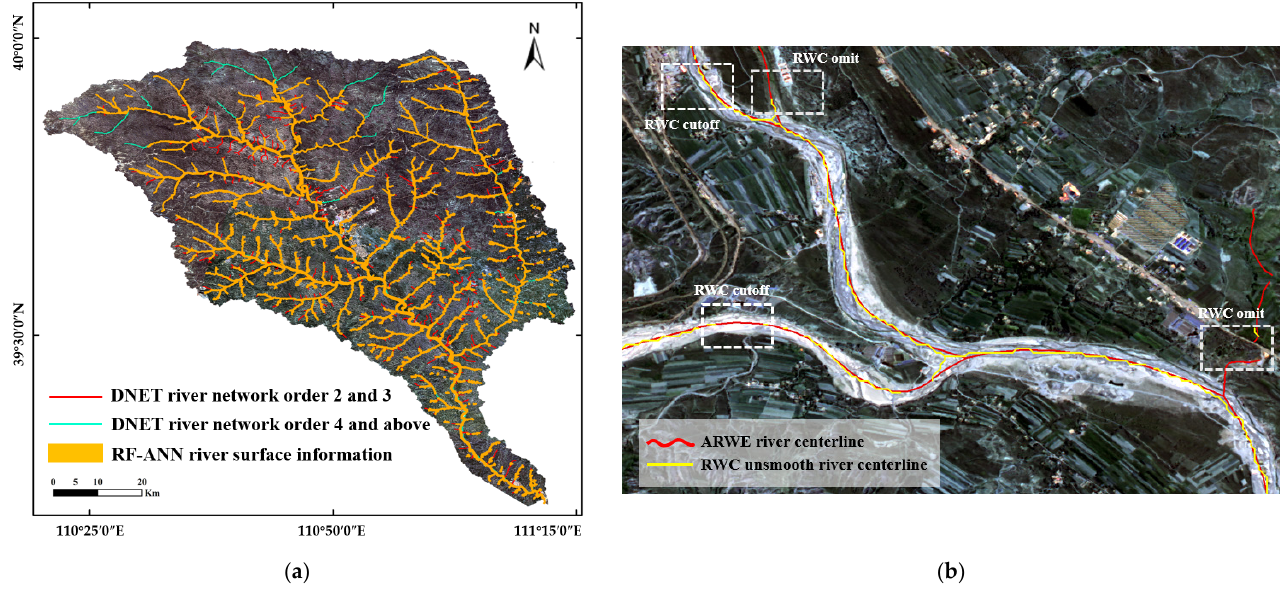
Figure 9. The extraction result of the river surface. ( a ) Comparisons between all the extracted rivers and river networks above order 2 that were generated from a 90-m resolution DEM. ( b ) Comparisons between RWC river centerline and ARWE river centerline. The cut-off and omit region of RWC river centerline was shown .